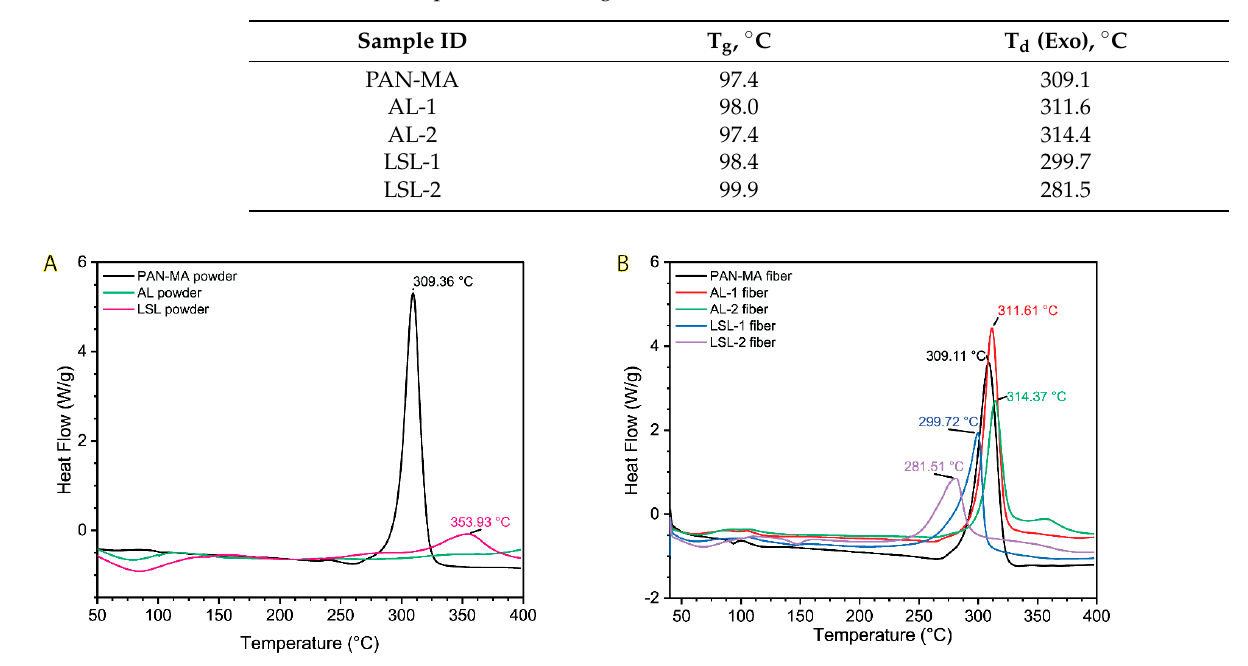
Table 2. Glass transition temperature (T g ) and decomposition temperature (T d ) [endothermic peaks] of 10 wt % electrospun PAN-MA/lignin nanofibers.